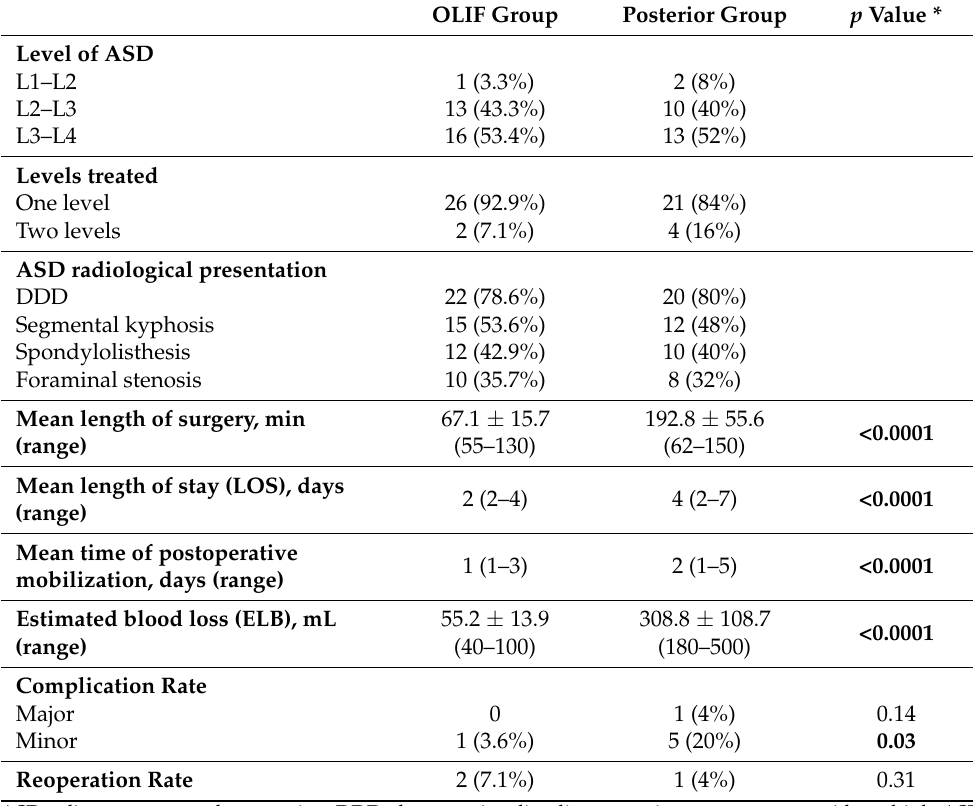
Table 2. Operative characteristics.